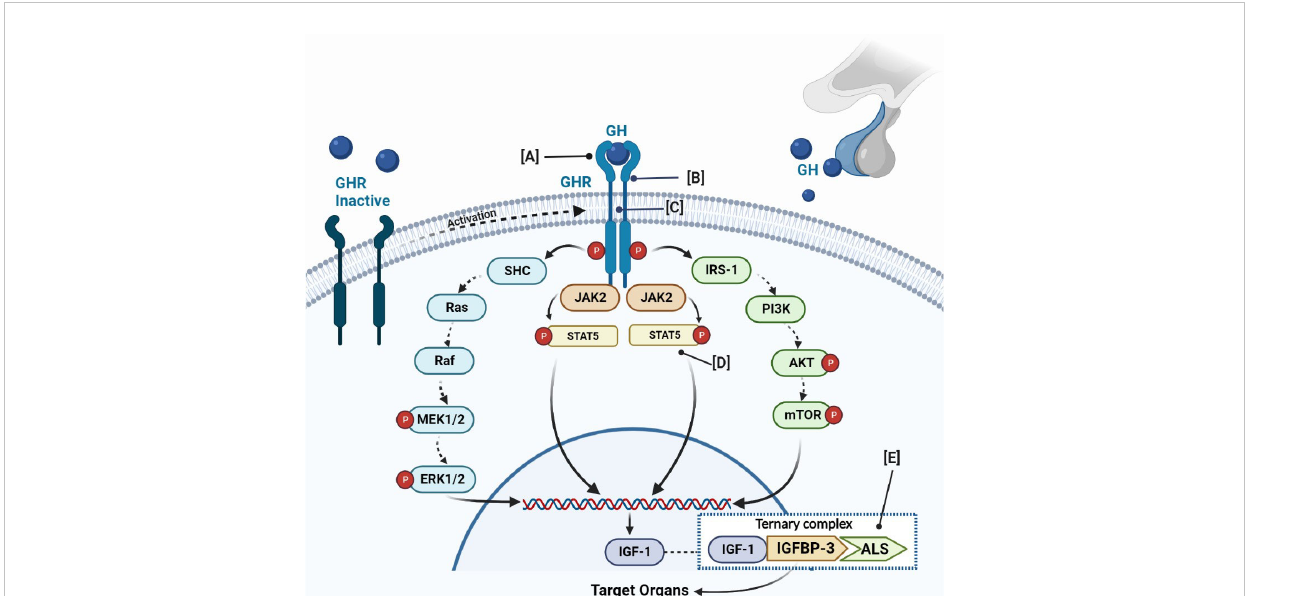
FIGURE 1 Schematic fi gure of GH-IGF-1 axis, its physiology, and main genetic defects related to GHI. The GH binds to a GHR, which activates JAK2 and promotes the phosphorylation of different members of the signal transducer. The fi nal result is the IGF-1 production. IGF-1 binds to IGFBP-3 or IGFBP-5 and the acid-labile subunit (ALS) and constitutes the ternary complex. (A) Defects of the extracellular domain of the GHR; (B) defects in GHR dimerization; (C) defects of the transmembrane domain of the GHR; (D) defects of STAT5b; (E) defects of IGFBP. GH, growth hormone; GHR, growth hormone receptor; JAK2, Janus family tyrosine kinase 2; PI3K, phosphatidylinositol-3 kinase; ERK, extracellular signal-regulated kinase; STAT, signal transducer and activator of transcription; IGF, insulin-like growth factor; IGFBP, IGF-binding proteins.; ALS, acid-labile